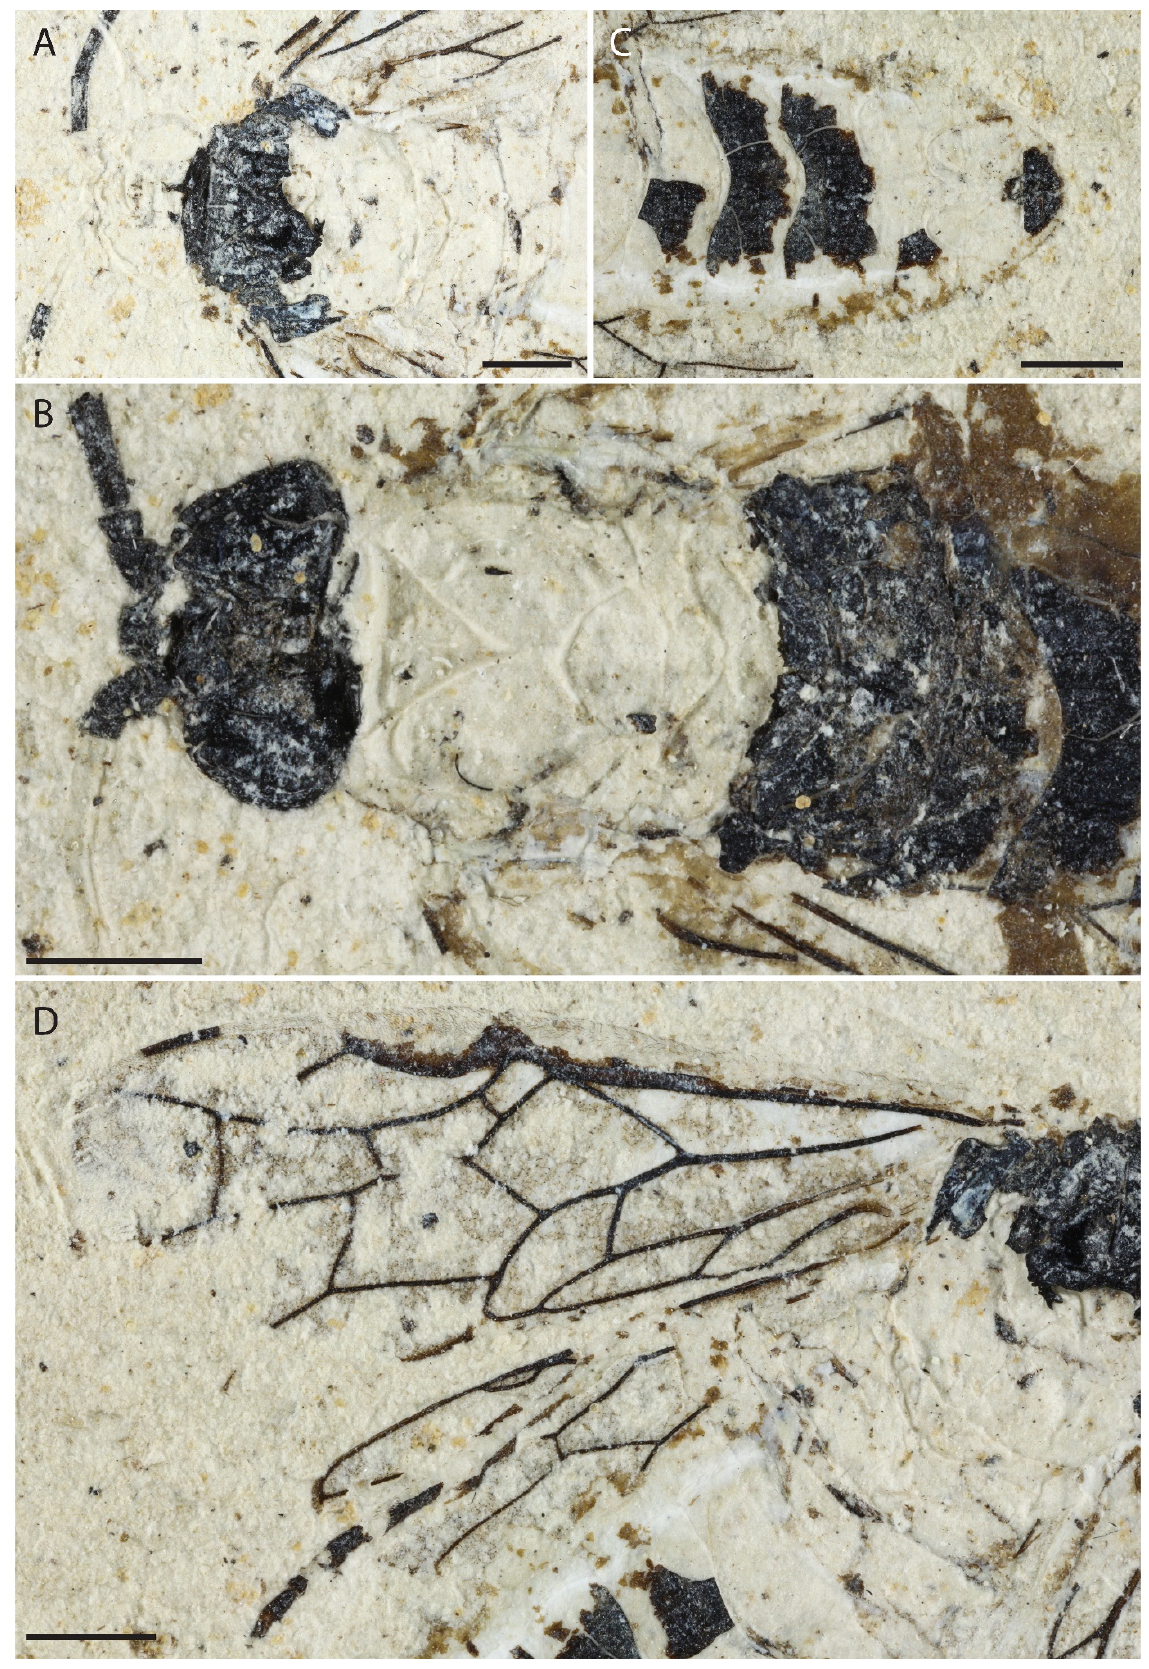
Figure 5. Empria sammuti sp. nov., holotype IGR-PAL-2860. Photographs. ( A ) Head and mesosoma. ( B ) Metasoma. ( C ) Head and mesosoma. ( D ) Wing venation. Scale bars = 1 mm.